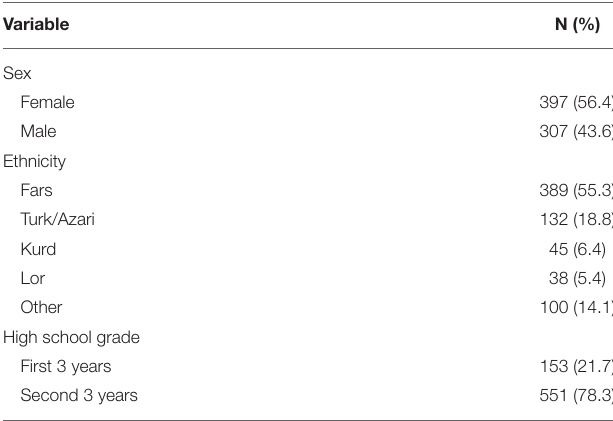
TABLE 1 | Sociodemographic characteristics of participants. Variable